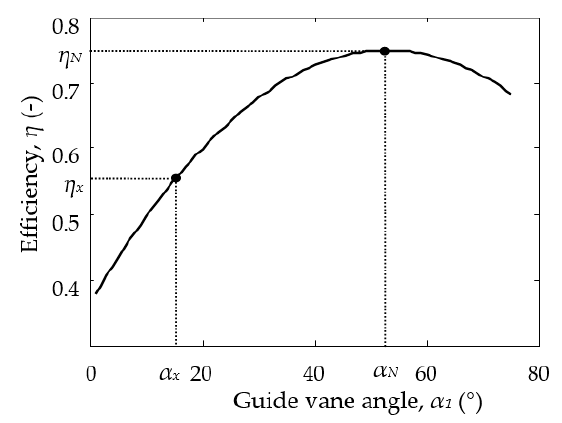
Figure 9. E ffi ciency function estimated by the parabola function. Figure 9. Efficiency function estimated by the parabola function. Figure 9. Efficiency function estimated by the parabola function.